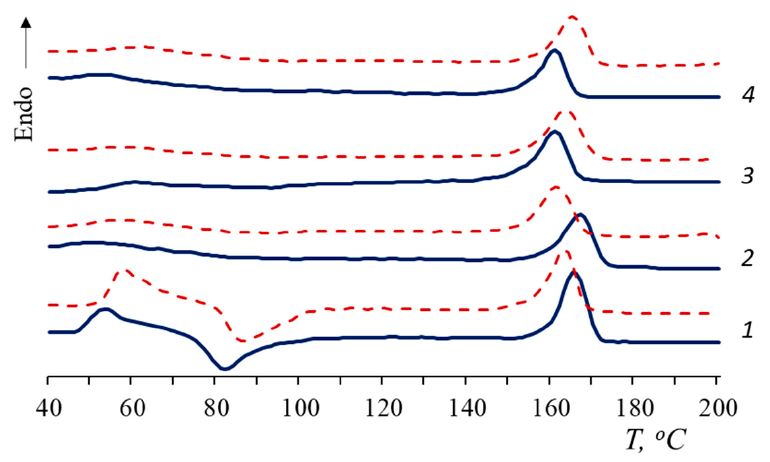
Figure 4. Melting thermograms of PLA/NR films. The content of NR, wt.%: (1) 0; (2) 5; (3) 10; and (4) 15. Blue: initial samples; red: after biotic degradation. Table 1. Thermophysical characteristics of PLA/NR fi lm samples: before and after biotic and hydro- lytic degradation.